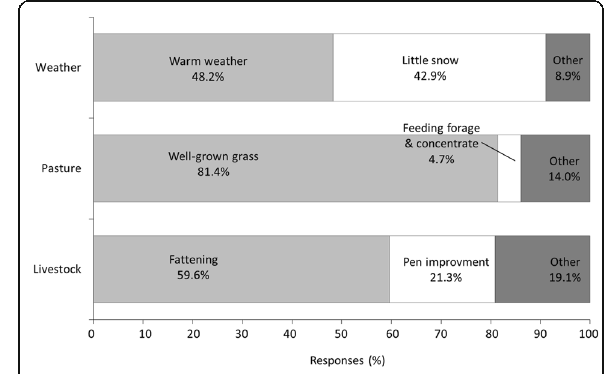
Figure 3 Weather and pasture conditions as well as livestock management options potentially reducing the severity of a dzud as perceived by 50 interviewed herders in the Mongolian